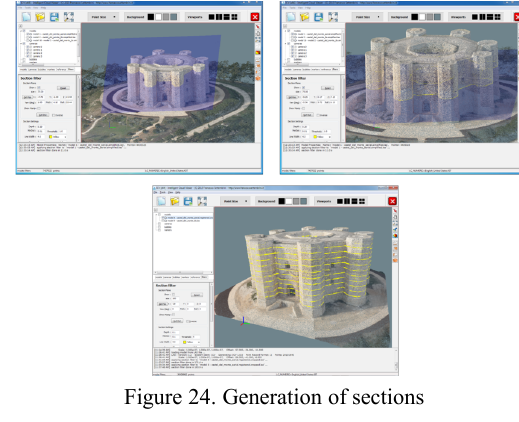
Figure 24. Generation of sections